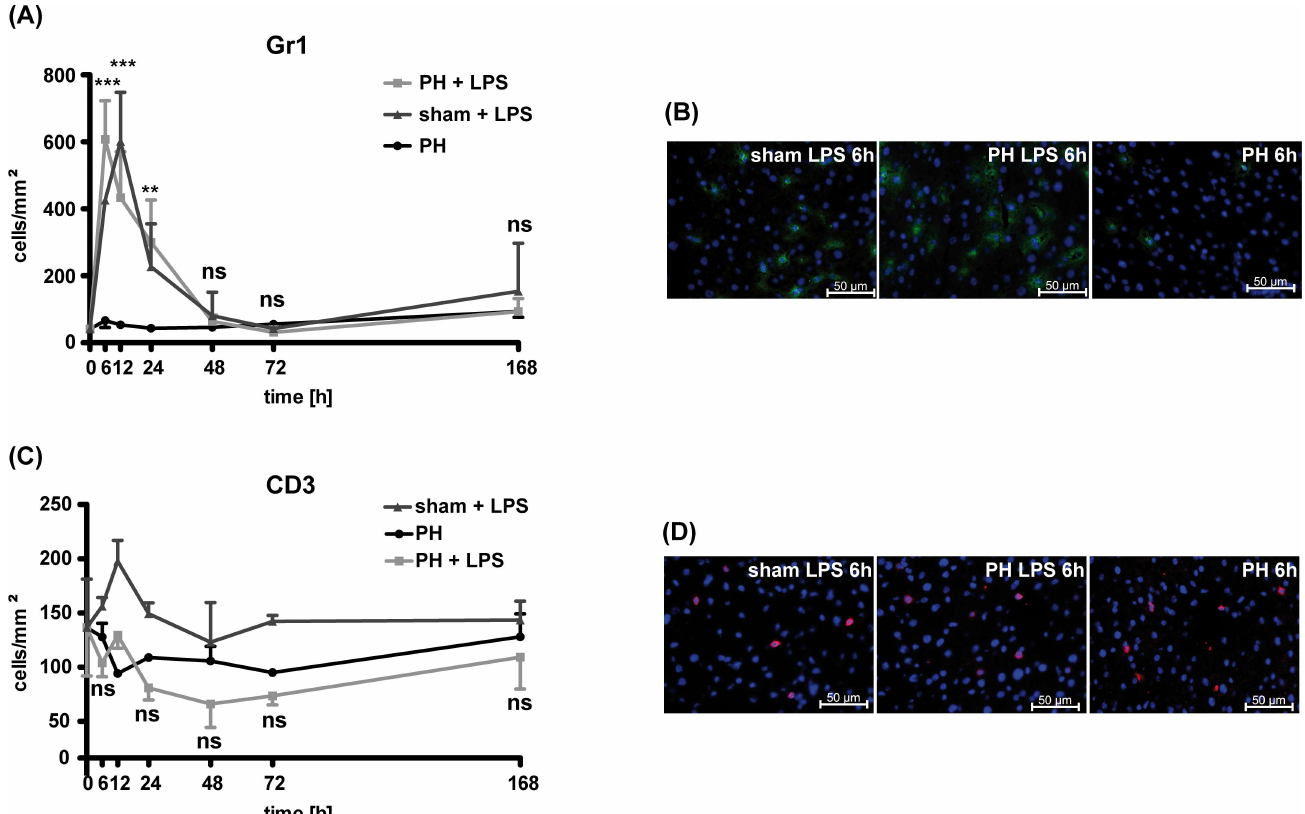
Fig 2. Characterization of immunocompetent cells in the regenerating liver. Number of Gr1 + (A) or CD3 + (C) immune cells per mm 2 liver parenchyma were quantified in the regenerating liver at distinct time points after PH, PH plus LPS applicationor sham-procedure plus LPS application in WT mice. The 0h timepointrepresentsliver tissue of WT mice (n = 2) without any treatment and before the operation(preoperative situation). Representative images for Gr1 + (B, green) or CD3 + (D, red) cells within the liver parenchyma 6h after sham procedure plus LPS, PH plus LPS or PH only in WT mice are shown. At least 5 sections per time point and treatment were analyzed.Each value representsthe mean ± SD from 3 independent mice per time point. Statistical significances were analyzedby two-way ANOVA-test and refer to the comparisonbetweenPH and PH and LPS application. Scale bars indicate 50 μ m.Gr1 + cells in green, CD3 + cells in red, nuclei in blue (DAPI).